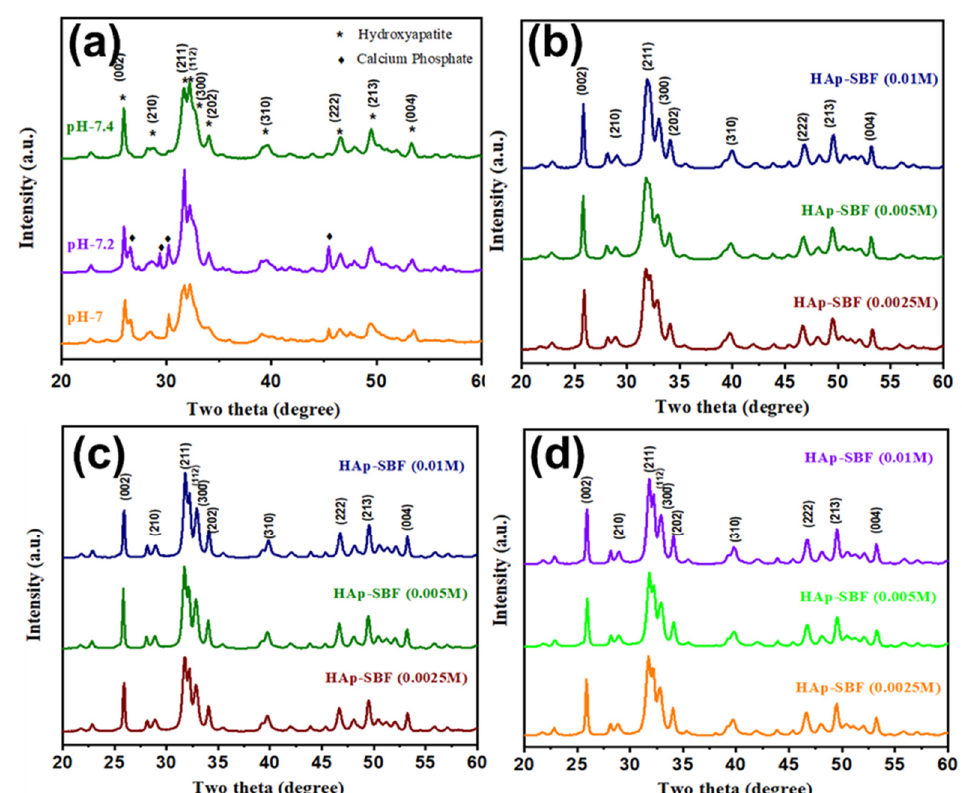
Figure 1. Powder XRD spectra of HAp and F-HAp ( a ): HAp synthesized in SBF at different pH values; ( b ): F-Hap synthesized in SBF at different concentrations of NaF; ( c ): HAp synthesized in SBF followed by 1 day soaking in solutions of different concentrations of NaF; ( d ): HAp synthesized in SBF followed by 3 days soaking in solutions of different concentrations of NaF.